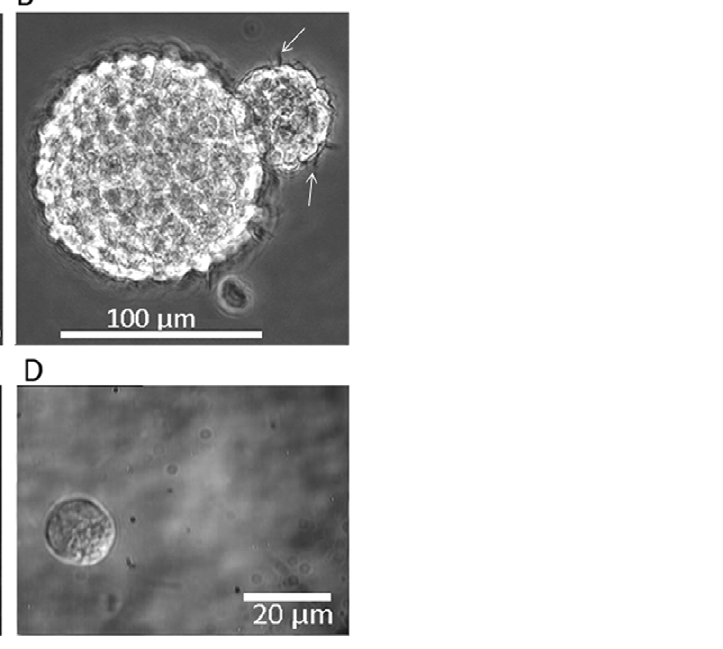
Figure 2. Phase contrast images of neurospheres and single neural progenitor cells from dissociated neurospheres. A) Two fused neurospheres; B) Fused neurospheres with filopodia visible on the surface; C) Differential interference contrast image of a single neural progenitor cell with filopodia; and D) a single neural progenitor cell without filopodia. Filopodia are indicated by white arrows.